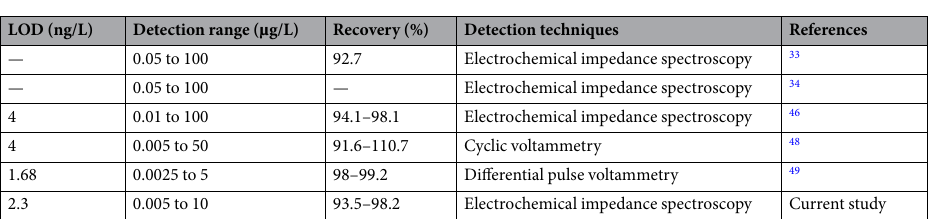
Table 2. MC-LR detection performance using most recent immuno-electrochemical biosensors in